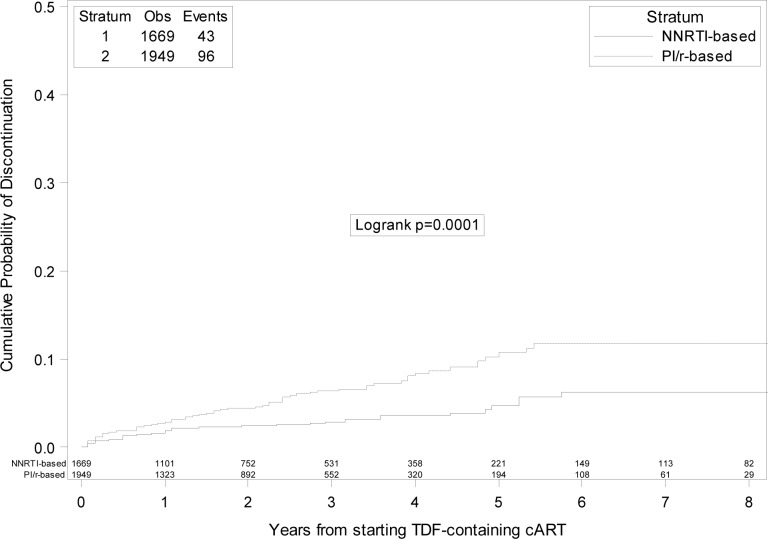
Kaplan-Meier estimates of risk of tenofovir discontinuation due to toxicity in boosted protease inhibitors versus non-nucleoside reverse transcriptase inhibitors groups.